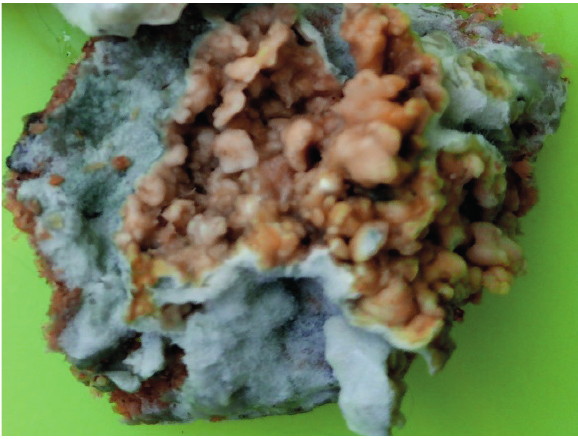
Figure 5 Fragment of plant plastics from wheat husk (without adhesives) with signs of mold growth